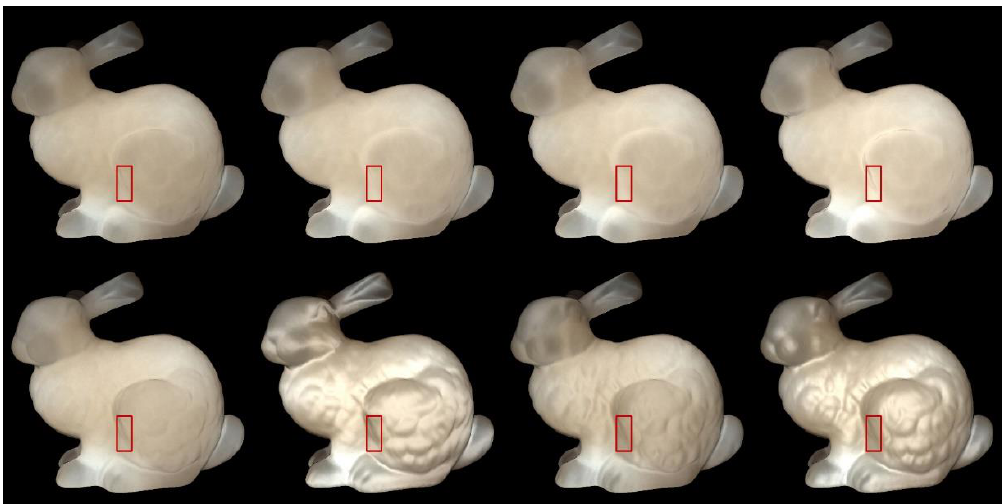
Figure 3. Comparison of highlight effects generated by our Ward-based method (first row) and the method based on the traditional Ward model (second row) for marble material. From left to right, the n t , n b parameters are n t is 2, n b is 2; n t is 2, n b is 10; n t is 10, n b is 2; n t is 10, n b is 10.